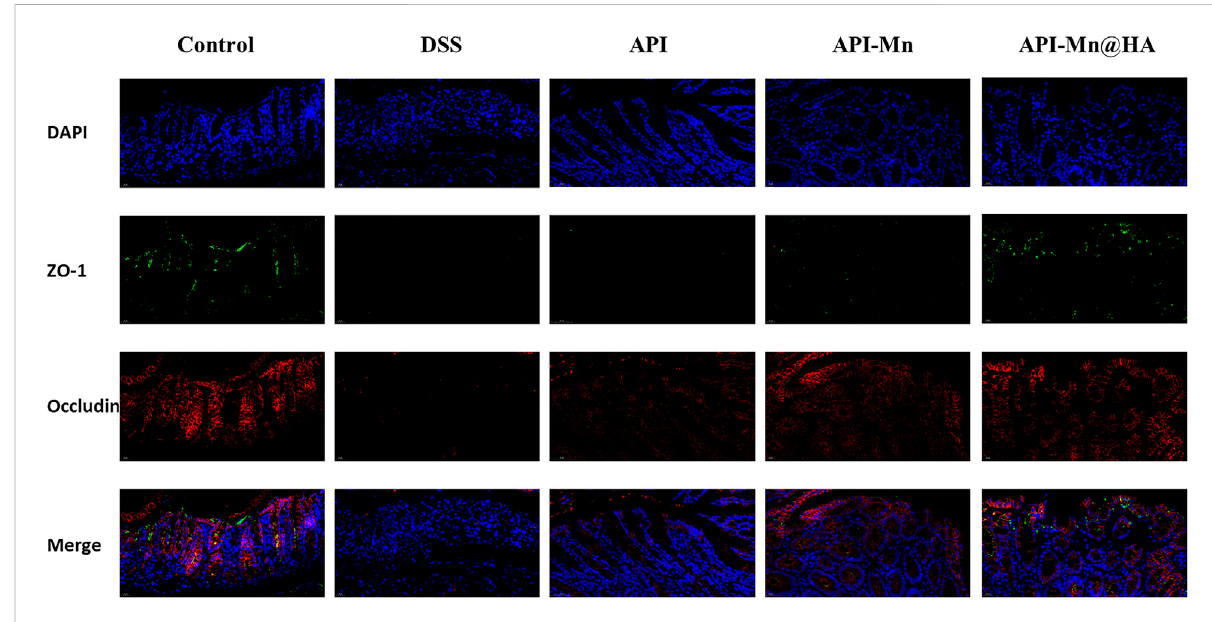
FIGURE 9 Immuno fl uorescence staining image of mice. Sections of tissue were stained with DAPI (blue) and ZO-1 (green) and Occludin